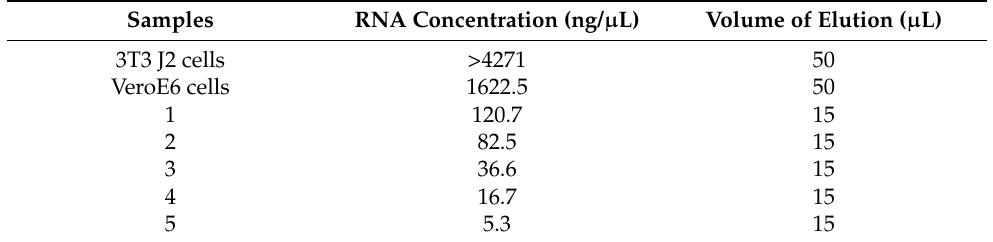
Table 2. Estimation of the RNA concentration from model cell lines and from the semen of five